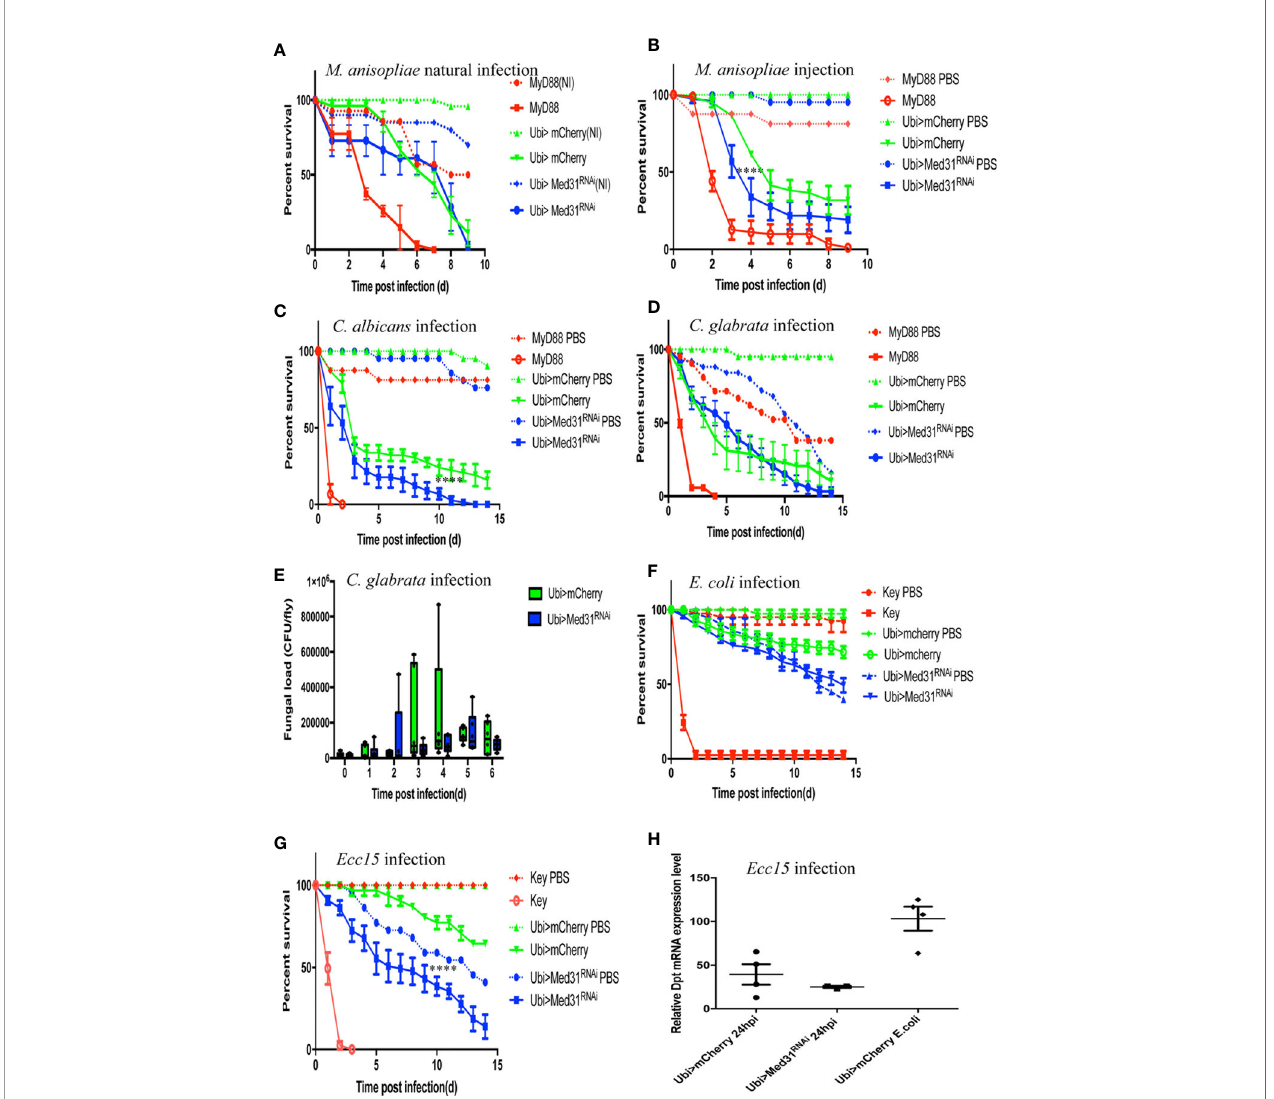
FIGURE 3 | Susceptibility of Med31 RNAi fl ies to other pathogens. Survival of Med31 RNAi fl ies challenged with other pathogens. MyD88 represents the positive control line (red) for fl ies infected with M. anisopliae , C. albicans , C. glabrata , and E. faecalis ; kenny , a member of the IMD pathway, is the positive control line (red) for fl y lines infected with Ecc15 or E. coli , Ubi> mCherry RNAi line corresponds to the wild type control line (green) and Ubi> Med31 RNAi line (blue). For each infected line a PBS-injected control was also performed (dotted lines). (A) Survival of Med31 RNAi fl ies after M. robertsii natural infection. The survival curve is representative of nine independent experiments. (B) Survival of Med31 RNAi fl ies following M. robertsii conidia injection. Infected Med31 RNAi fl ies vs. infected mCherry RNAi fl ies: log-rank test, ****P < 0.0001. The survival curves are representative of fi ve independent experiments. (C) Survival of Med31 RNAi fl ies following C. albicans infection. Infected Med31 RNAi fl ies vs. infected mCherry RNAi fl ies: log-rank test, ****P < 0.001. The survival curves are representative only of two out of four independent experiments, the other two not displaying any difference between Med31 RNAi and control fl ies. (D, E) Survival of Med31 RNAi fl ies and the fungal load following C. glabrata infection. The survival curves are representative of nine independent experiments. (F) Survival of Med31 RNAi fl ies following E. coli infection. The survival curves are representative of two independent experiments. (G) Survival of Med31 RNAi fl ies after Ecc15 challenge. The survival curves are representative of nine experiments. (H) Diptericin expression level normalized to the Rpl32 house keeping gene at 24 h post infection with Ecc15 . Each dot represents one sample containing four fl ies. Septic infection with E.coli was a positive control for Diptericin expression. Mean ± SEM are indicated, except for 3E where the median is